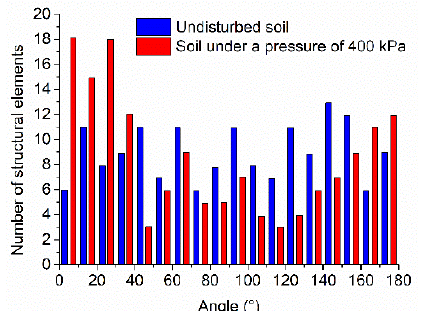
Figure 7. Directional particle distribution of structural elements under a stress of 400 kPa.